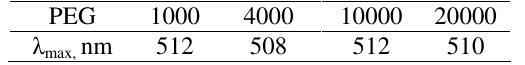
Table 2. MW and maximum absorbance wavelength of